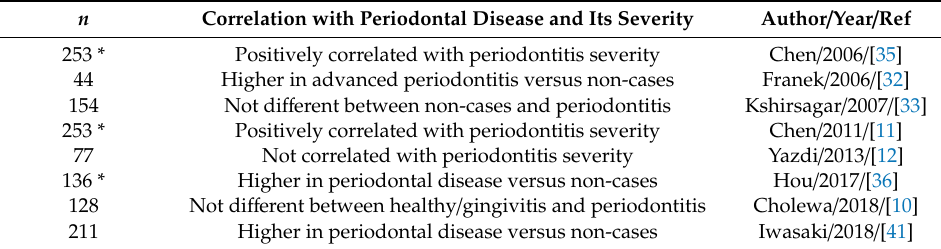
Table 2. Relationships between serum C-reactive protein level and periodontal